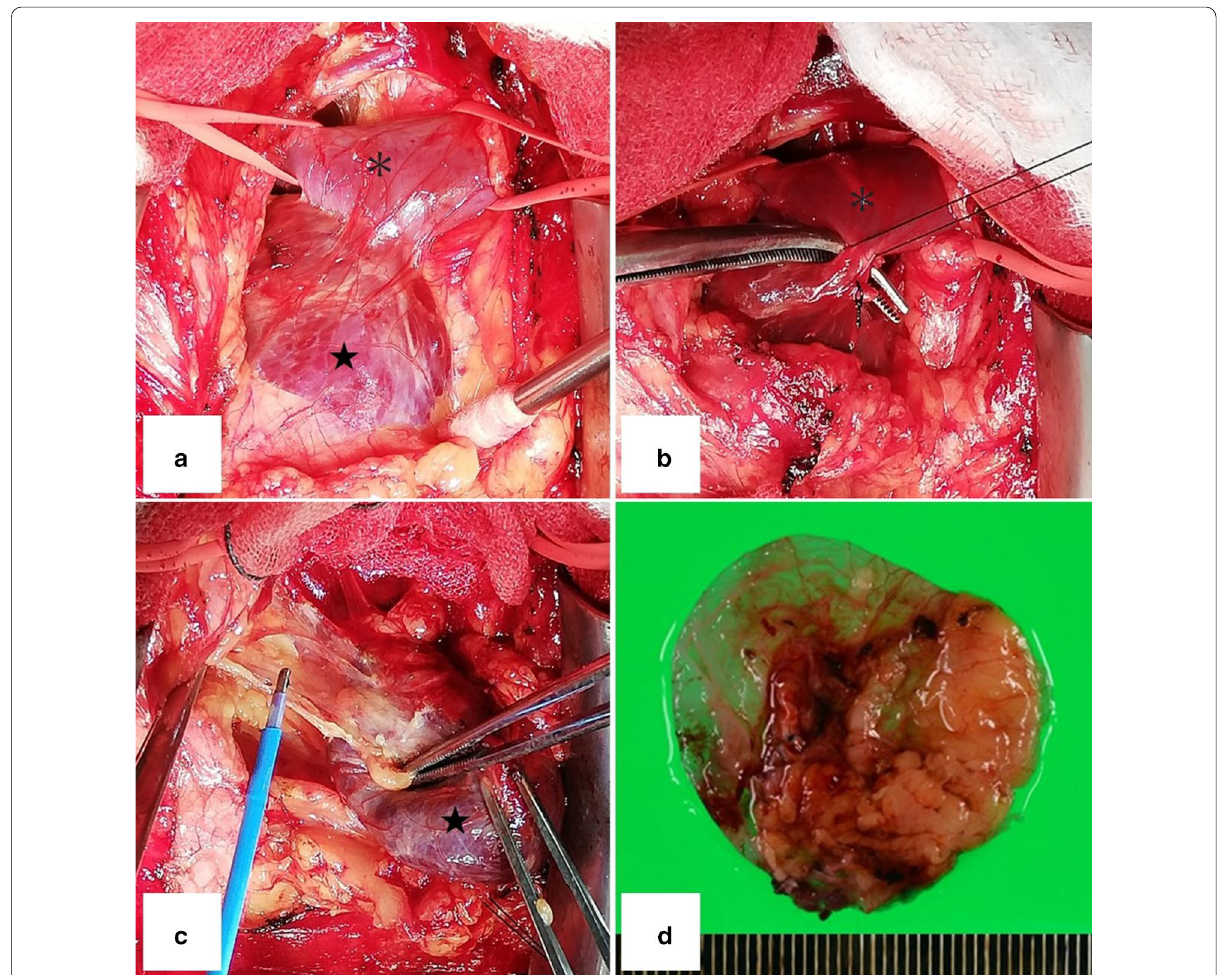
Fig. 2 The aneurysm (star) was easily dissected from the thymic adipose tissue for the most part, but parts of the aneurysm wall were fragile. The central and peripheral sides of the brachiocephalic vein (asterisk) were secured ( a ). The brachiocephalic vein (asterisk) and aneurysm (star) were attached by the neck of the aneurysm, which was 8 mm in diameter and was ligated and dissected ( b ). Aneurysm (star) was not connected to superior vena cava ( c ). Some parts of the venous walls were thin and fragile ( d